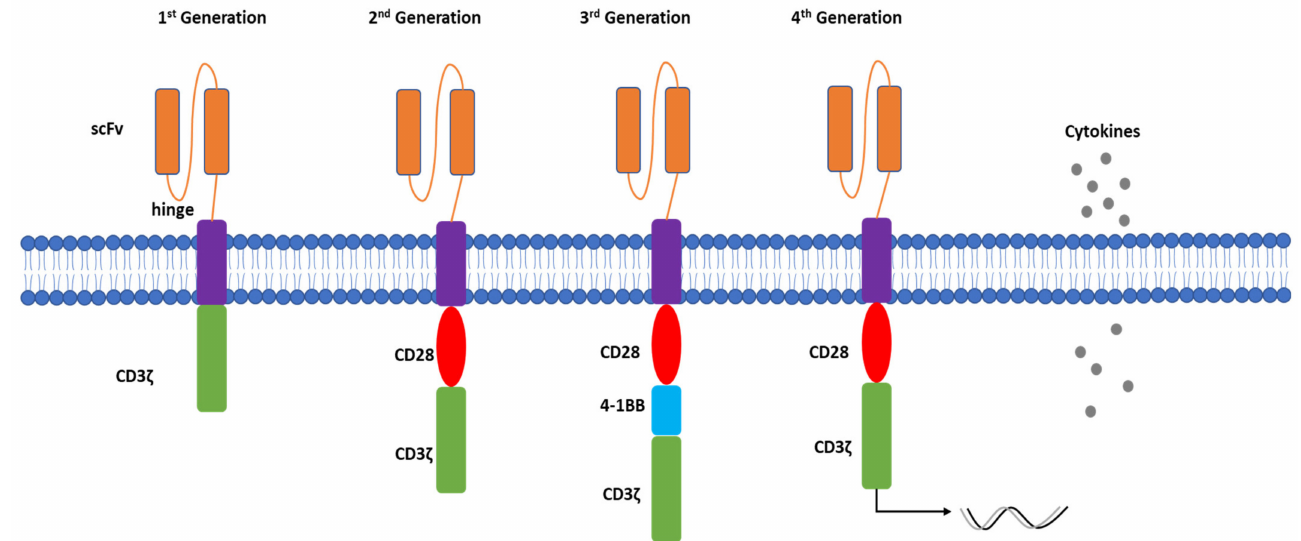
Figure 2. Four generations of CAR-T cells. First generation CARs comprise of single chain variable fragment (scFv) antibody (orange) fused to transmembrane domain (purple) to TCR signaling component of CD3 ζ (green) at the cytoplasmic tail. Second generation CARs have a CD28 co- stimulatory signaling domain (red) which enhances proliferation and cytotoxicity. Third generation CARs contain an additional co-stimulatory domain, 4-1BB (blue) to the second generation CARs which enhances proliferation, minimizes T cell exhaustion and improves CAR-T cells persistence. Fourth generation CARs also called “T cell directed for universal cytokine-mediated killing” (TRUCKs) are engineered to secrete cytokines (gray) to attract immune cells (NK and